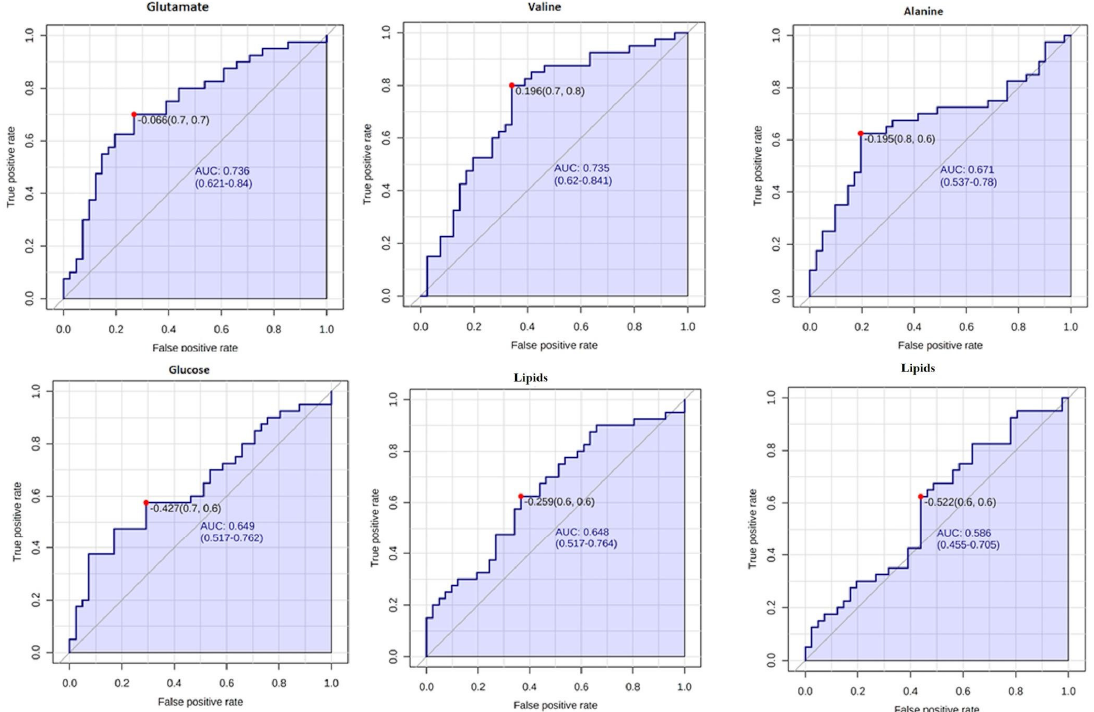
Figure A2. Receiver operating characteristic (ROC) curves of serum metabolites that distinguished thrombosis. The greatest area ‐ under ‐ the ‐ ROC ‐ curve (AUC = 0.73) value was obtained for glutamate and valine. The optimal cutoff was represented on the curve with a red dot and with a line on the box plot.